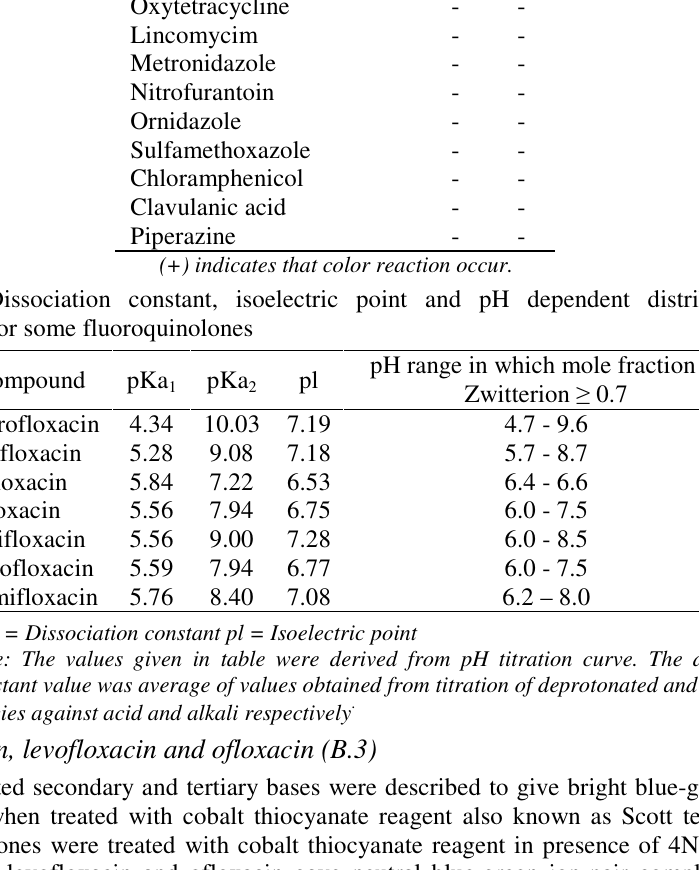
Table 1. Selectivity of A.1 and A.2 color reaction for fluoroquinolones.